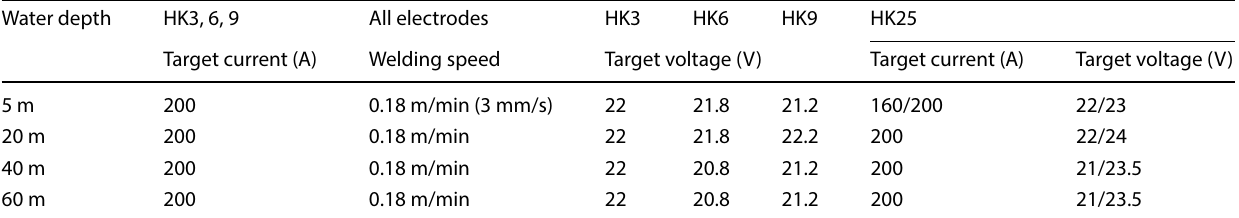
Table 2 Targeted welding